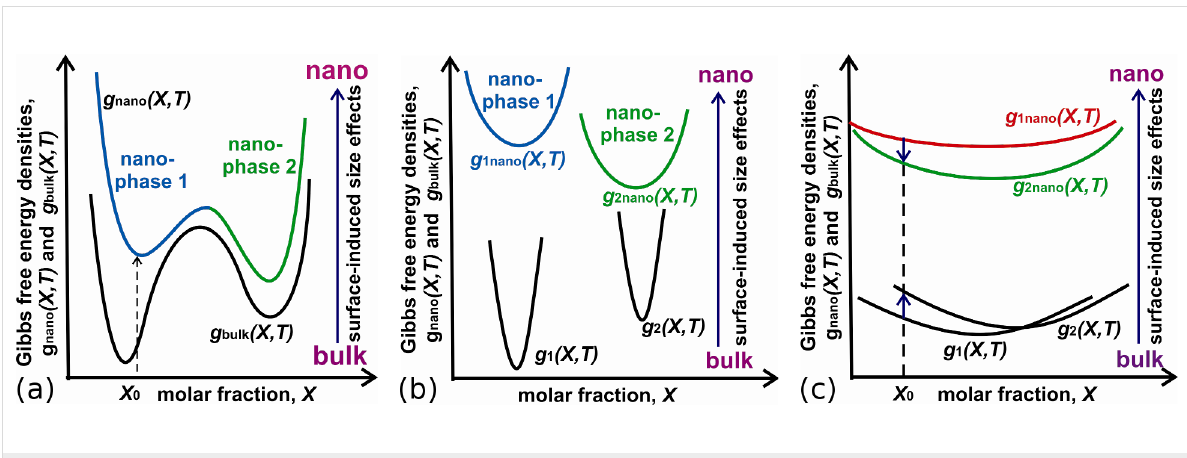
Figure 1: Surface-induced size effect on the shift of equilibrium states and solubility limits when the metastable in a bulk phase 2 becomes stable one in a nanometric volume: (a) – composition dependence of energy density for the solution case, (b) – case of parabolic dependences of Gibbs free energy densities of different phases, (c) – case of a isoconcentrational transformation. Black color curves g bulk ( X , T ), g 1 ( X , T ) and g 2 ( X , T ) characterize the energy density dependence on composition for given phases in a bulk case, color curves g nano ( X , T ) , g 1nano ( X , T ) and g 2nano ( X , T ) are shifted Gibbs free energy densities of given phases due to Laplace pressure. The value X 0 is the initial composition. The solubilities of chemical elements are shifted as compared with bulk situation (if one uses the rule of common